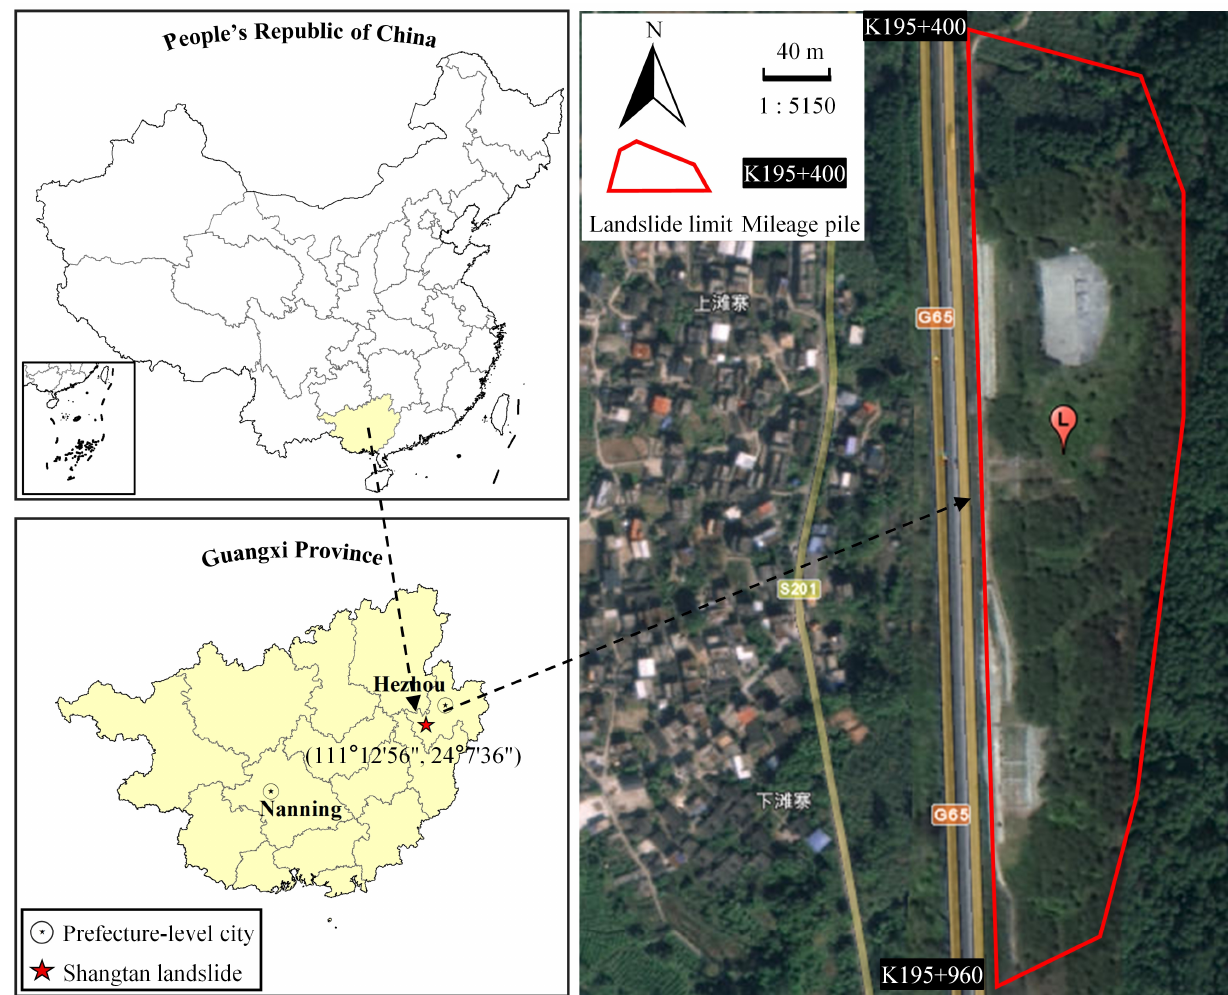
Figure 1. Location of the study site.